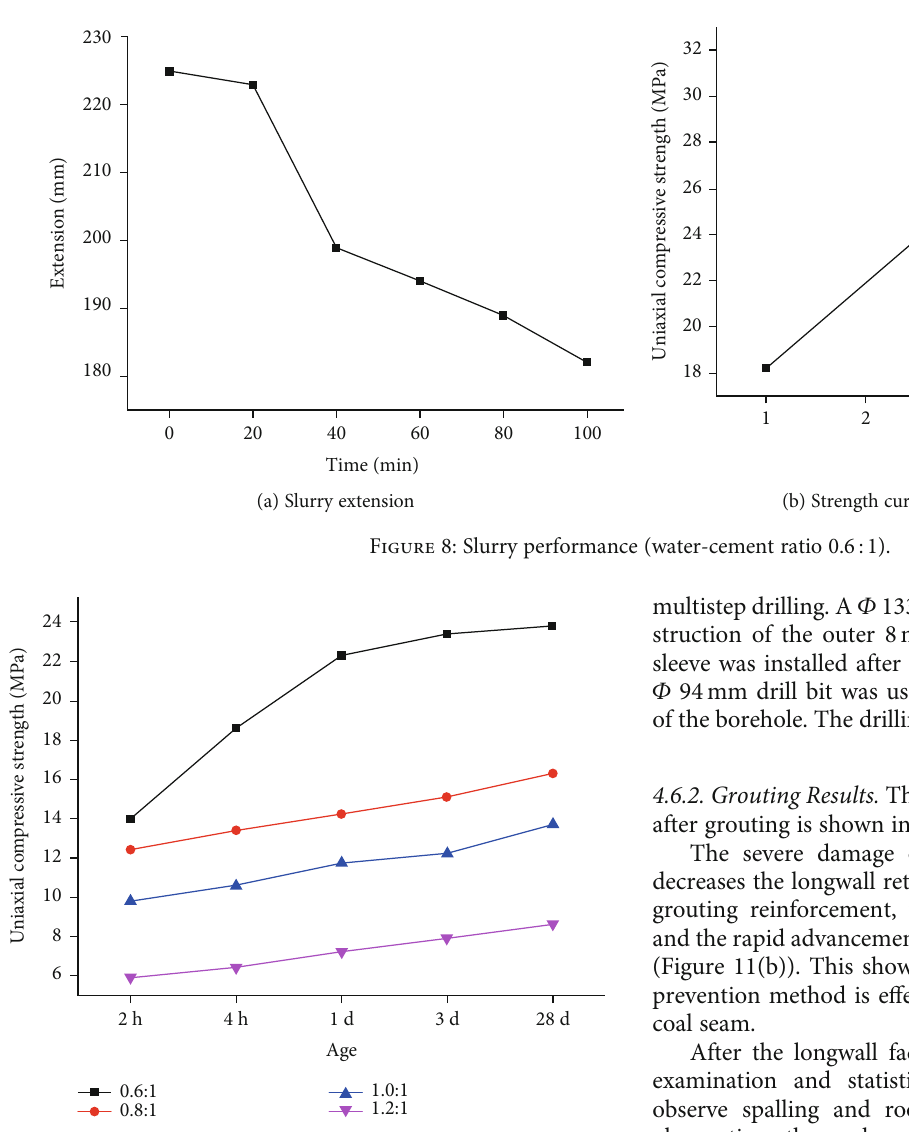
Figure 9: Strength development process of the new inorganic grouting material with varying water